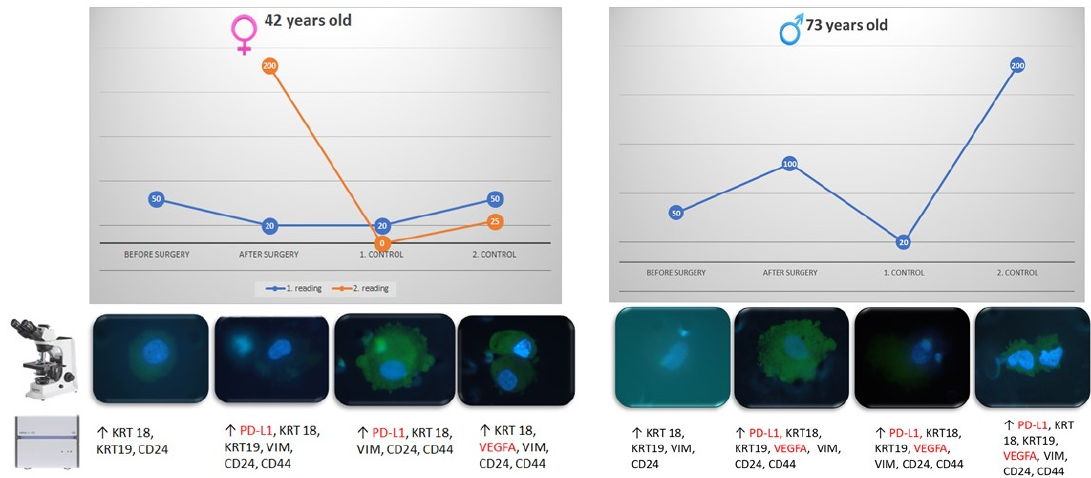
Figure 5. CTC follow-up during one-year period. We demonstrate changes during the four samplings not only in the CTC number (graph lines) and cytomorphology, but also in the gene expression (see elevated genes in CTCs below). Some of the genes with elevated expression could be used as markers to indicate specific therapy targets (e.g., VEGF, PD-L1). PD-L1 and VEGF expressions are shown in red.